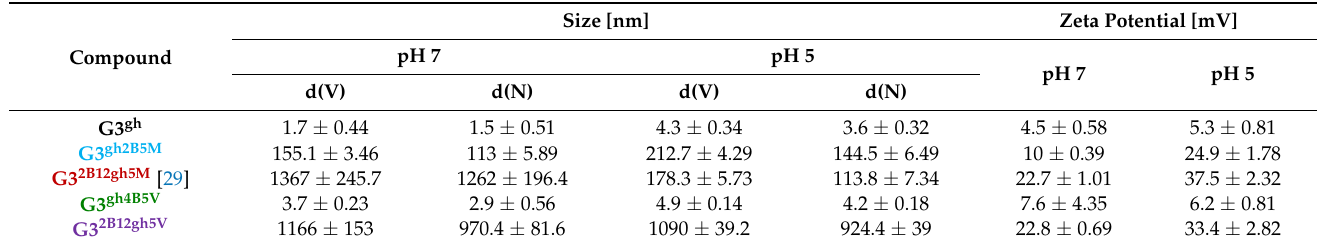
Table 1. Size of conjugates averaged by volume (d(V)) and by number of molecules (d(N)) and zeta potential values ± standard deviation determined by DLS